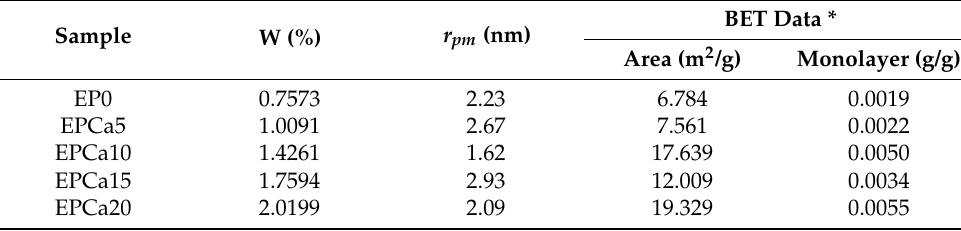
Table 4. Parameters estimated from